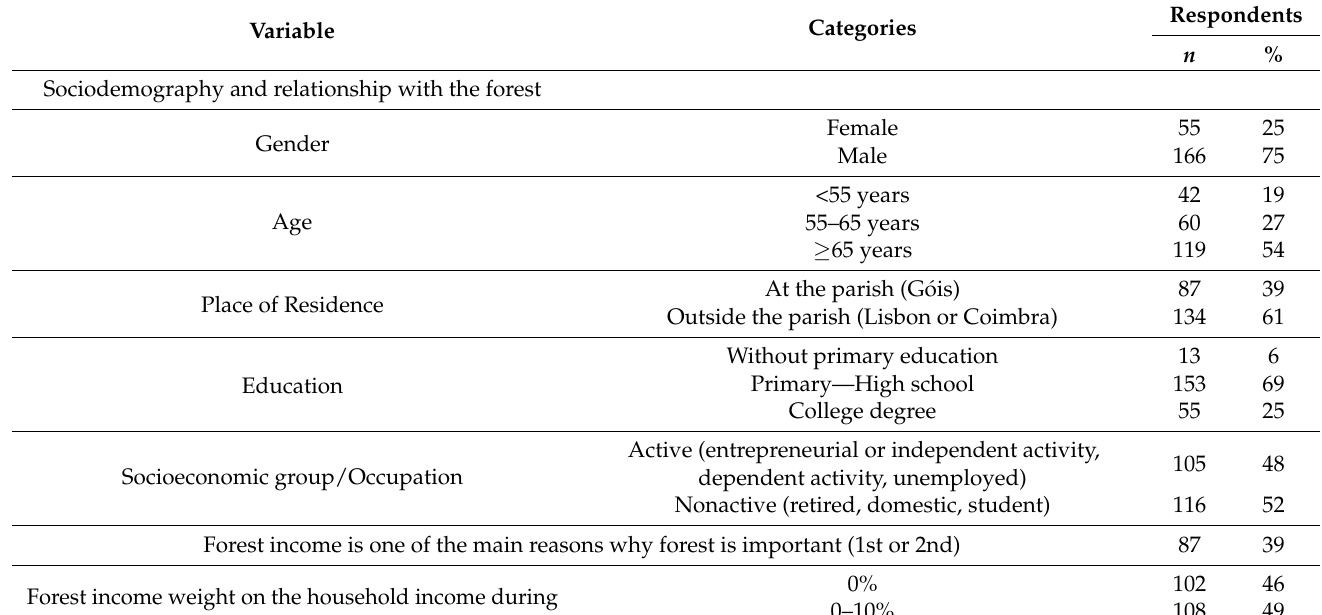
Table 2. Owners, forest management and wildfires (number and % of respondents, total =